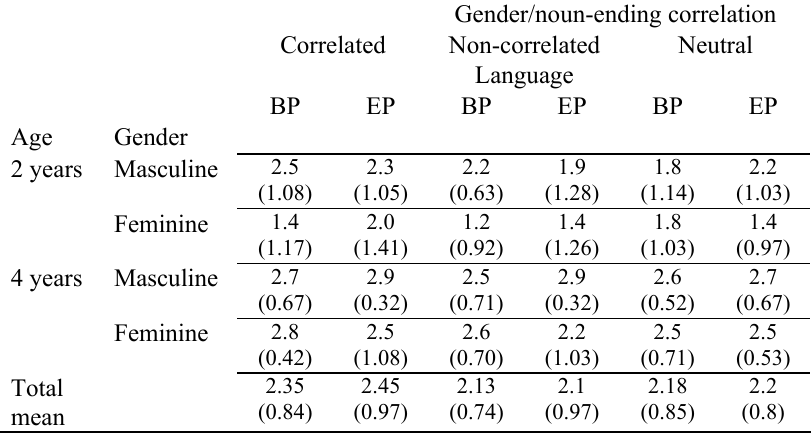
Table III: Means (standard deviations) as a function of gender/noun-ending correlation, grammatical gender, age and language (max score